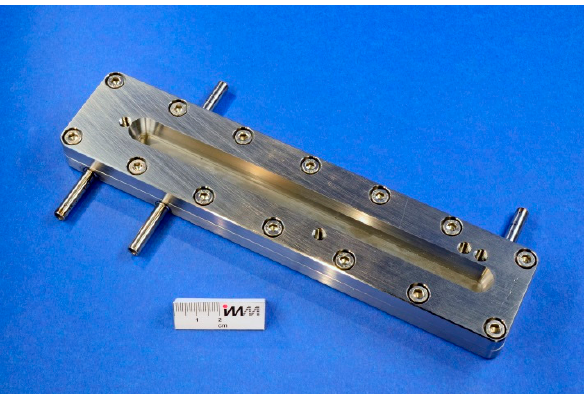
Figure 2. Mounted orifice microreactor, view on the inspection window for infrared measurements. The obtained conversion and yield at different reaction temperatures is shown in Figure 3 for a total flow rate of 10.5 mL·min − 1 .